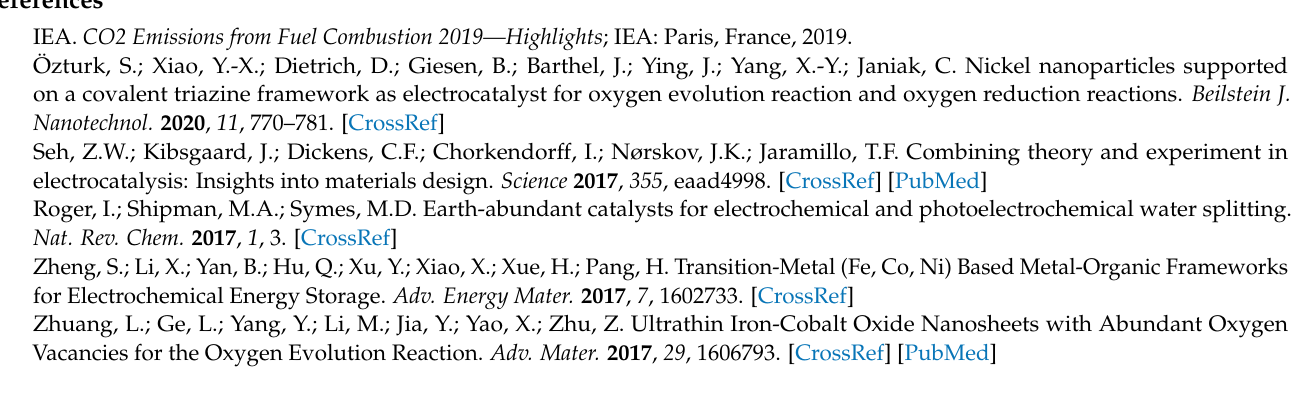
Table S1. Elemental analysis of the MOF samples. Table S2. Assignments of IR-bands of Ni-BTC analogs (cm − 1 ). Table S3. BET-surface areas and total pore volumes of the Ni-BTC analogs. Table S4. Overpotentials (at 10 mA/cm 2 ) and Tafel slopes for Ni 10 Fe-BTC, Ni 10 Co-BTC, Ni 10 Co-BTC/KB, KB and Ni/NiO nanoparticles done with a GCE (loading: 0.2 mg/cm 2 ) with a scan rate of 5 mV/s in a 1.0 mol/L KOH electrolyte. Figure S1. TGA curves of (a) Ni 10 Fe-BTC, (b) Ni 10 Co-BTC, (c) Ni 10 Co- BTC/KB and (d) KB under N 2 atmosphere with a heating rate of 5 K/min. Figure S2. SEM-EDX spectra of (a) Ni 10 Fe-BTC, (b) Ni 10 Co-BTC and (c) Ni 10 Co-BTC/KB. Figure S3. (a,b) SEM images and (c) SEM-EDX spectra of KB. Figure S4. TEM images of Ni 10 Fe-BTC (a) before (shown particle size: 3.1 µ m) and (b–d) after 1000 CVs. Figure S5. TEM images of Ni 10 Co-BTC (a) before and (b–d) after 1000 CVs (shown particle size in (b): 2.8 µ m; displayed particles in (c) give the average diameter of 20 nm ± 9 nm; (d) the lattice spacings and grain boundaries are illustrated in red and red lines, respectively). Figure S6. TEM images of Ni 10 Co-BTC/KB (a) before (shown particle size: 4.4 µ m) and (b,c) after 1000 CVs ((c) the lattice spacings and grain boundaries are illustrated in red and red lines, respectively.) and (d) histogram of Ni 10 Co-BTC/KB after 1000 CVs determined from (b) give the average diameter of 5 nm ± 1 nm (1 σ ). Scheme S1. Schematic relation between β -Ni(OH) 2 , α -Ni(OH) β -NiOOH and γ -NiOOH. Figure S7. FT-IR spectra of (a) Ni 2 , 10 Co-BTC after 24 h in 1 mol/L KOH (dark green) and (b) comparison with Ni 10 Co-BTC (green), (c) Ni 10 Co-BTC/KB after 24 h in 1 mol/L KOH (brown) and (d) comparison with Ni 10 Co-BTC/KB (orange), (e) Ni 10 Fe-BTC after 24 h in 1 mol/L KOH (purple) and (f) comparison with Ni 10 Fe-BTC (red). Table S5. Assignments of IR-bands of Ni-BTC analogs after 24 h in 1 mol/L KOH (cm − 1 ). References [82–84] are cited in the supplementary